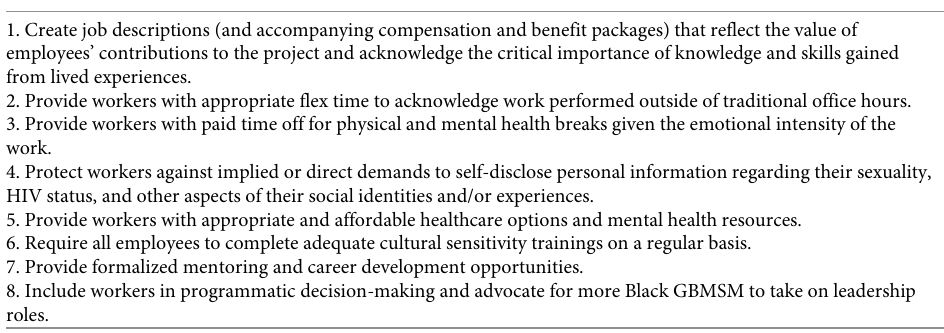
Table 2. Recommendations for improving the experiences of Black GBMSM working in HIV prevention and